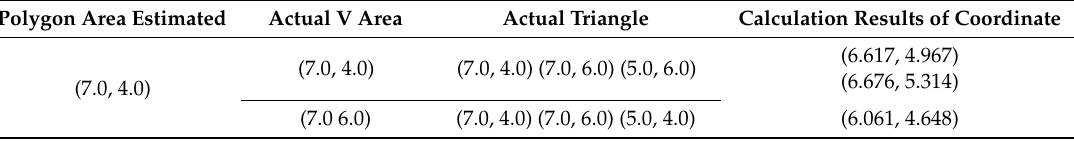
Table 4. The localization results with RSSI fluctuating 10%.